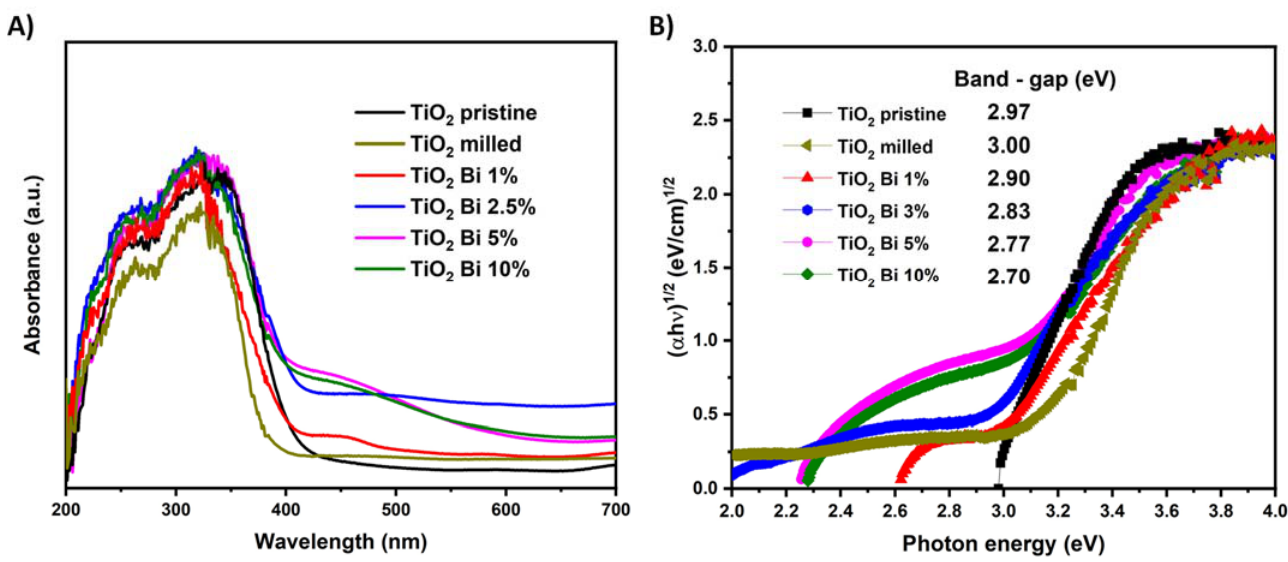
Figure 8. UV–vis diffuse reflectance absorption spectra ( A ) and Tauc plot ( B ) of pristine TiO 2 , milled TiO 2 , and Bi ‐ doped TiO 2 samples. Table 3. E g values of Bi ‐ doped TiO 2 samples obtained by mechanosynthesis compared with the re ‐ ported values in the literature for Bi ‐ doped TiO 2 samples obtained with other methods.